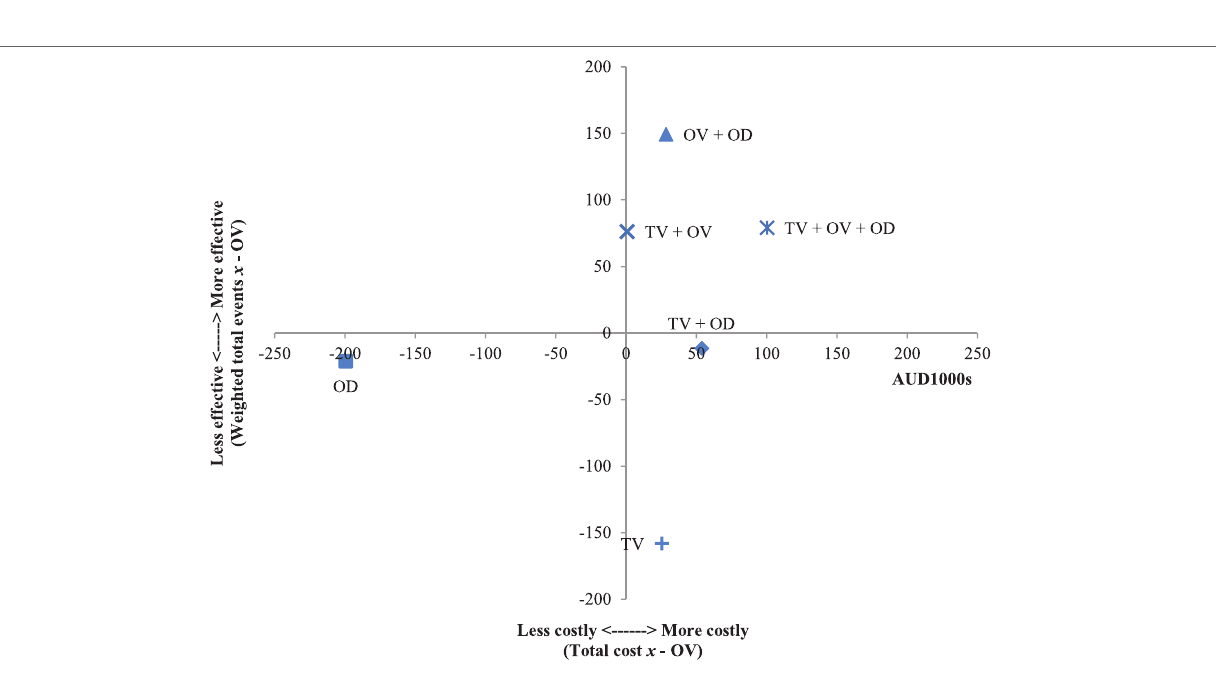
FiguRE 1 | Incremental cost-effectiveness of each format compared with television (TV). The cost-effectiveness of TV forms the baseline (cross-section of x and y axes). Effectiveness is weighted total events of each format ( x ) compared with TV. Cost is total costs in AUD1,000s of each format ( x ) compared with TV. Data points that fall in the upper left quadrant represent formats that are more cost-effective than TV.